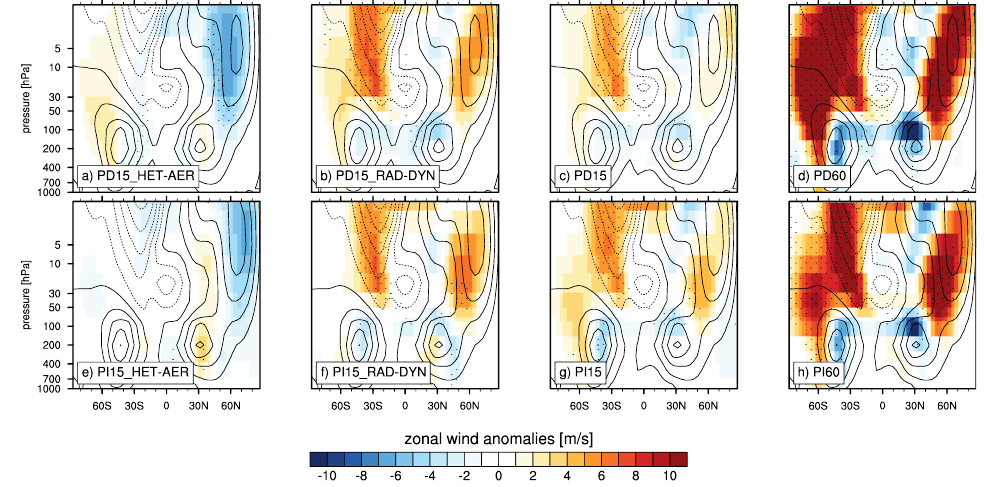
Figure 6. Similar to Fig. 5, but for the zonal mean zonal wind anomalies (ms − 1 ).